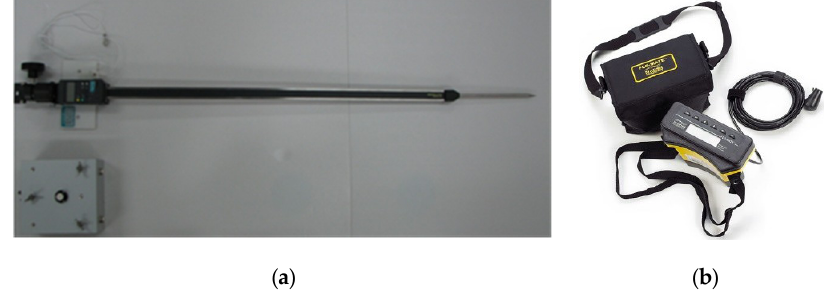
Figure 6. Observation station: ( a ) digital point gauge; ( b ) one-dimensional electronic hydrometer.